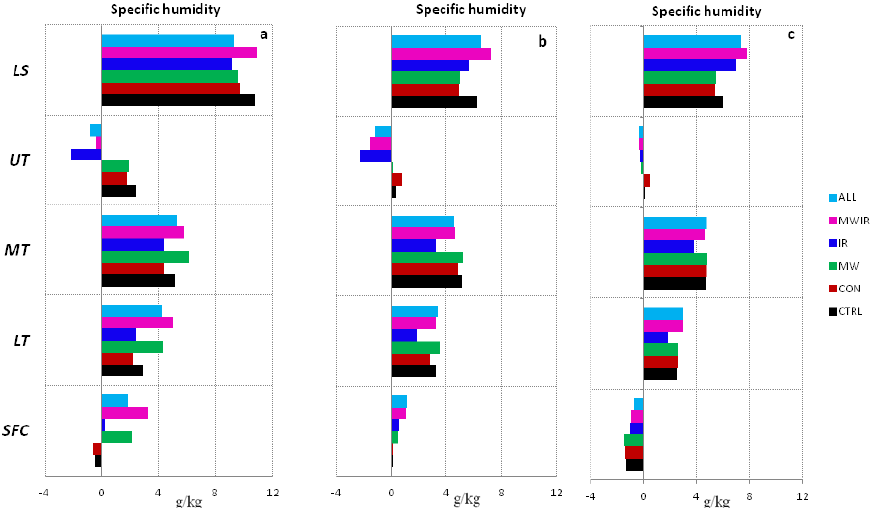
Figure 9. Bias profile of the specific humidity forecasts at (a) 6h, (b) 30h, (c) 54h forecasts. Unit: gkg − 1 . Other definitions are the same as in Fig.